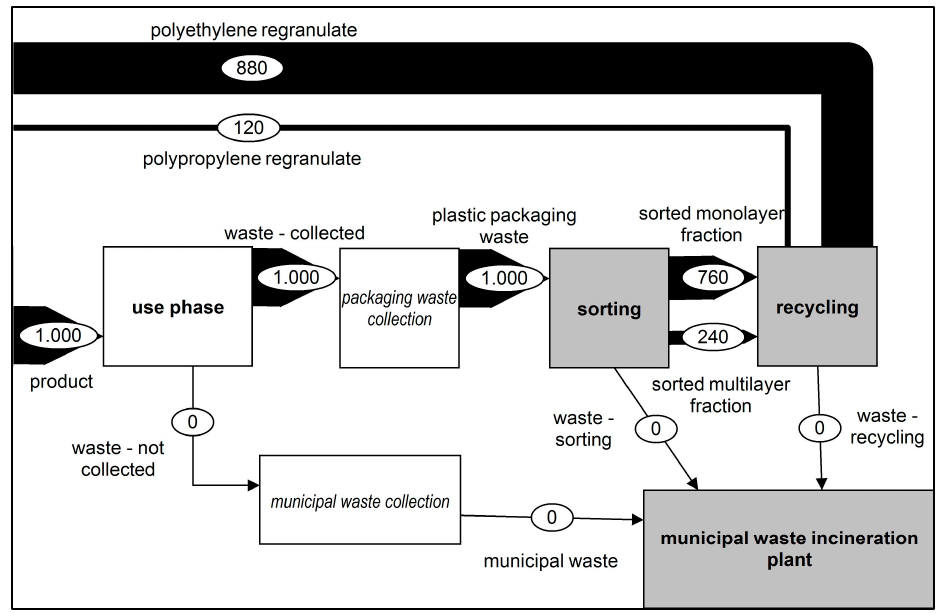
Figure 6. Representation of the optimised material flows—Scenario 4. Scenario 5: Recycling Goals 2025—Optimisation of Collection, Sorting and Mechanical Recycling